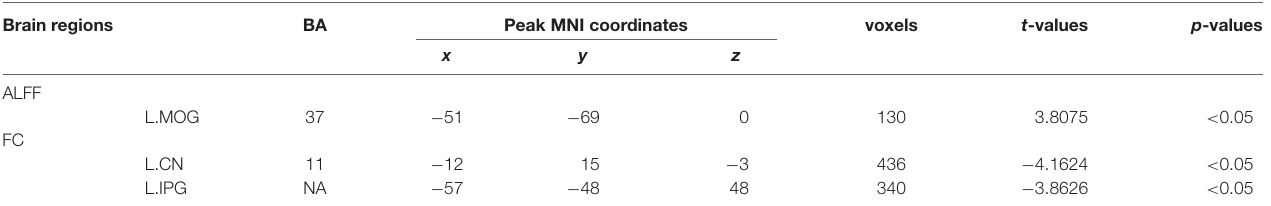
TABLE 3 | The brain regions with aberrant amplitude of low-frequency fluctuations (ALFF) and functional connectivity (FC).